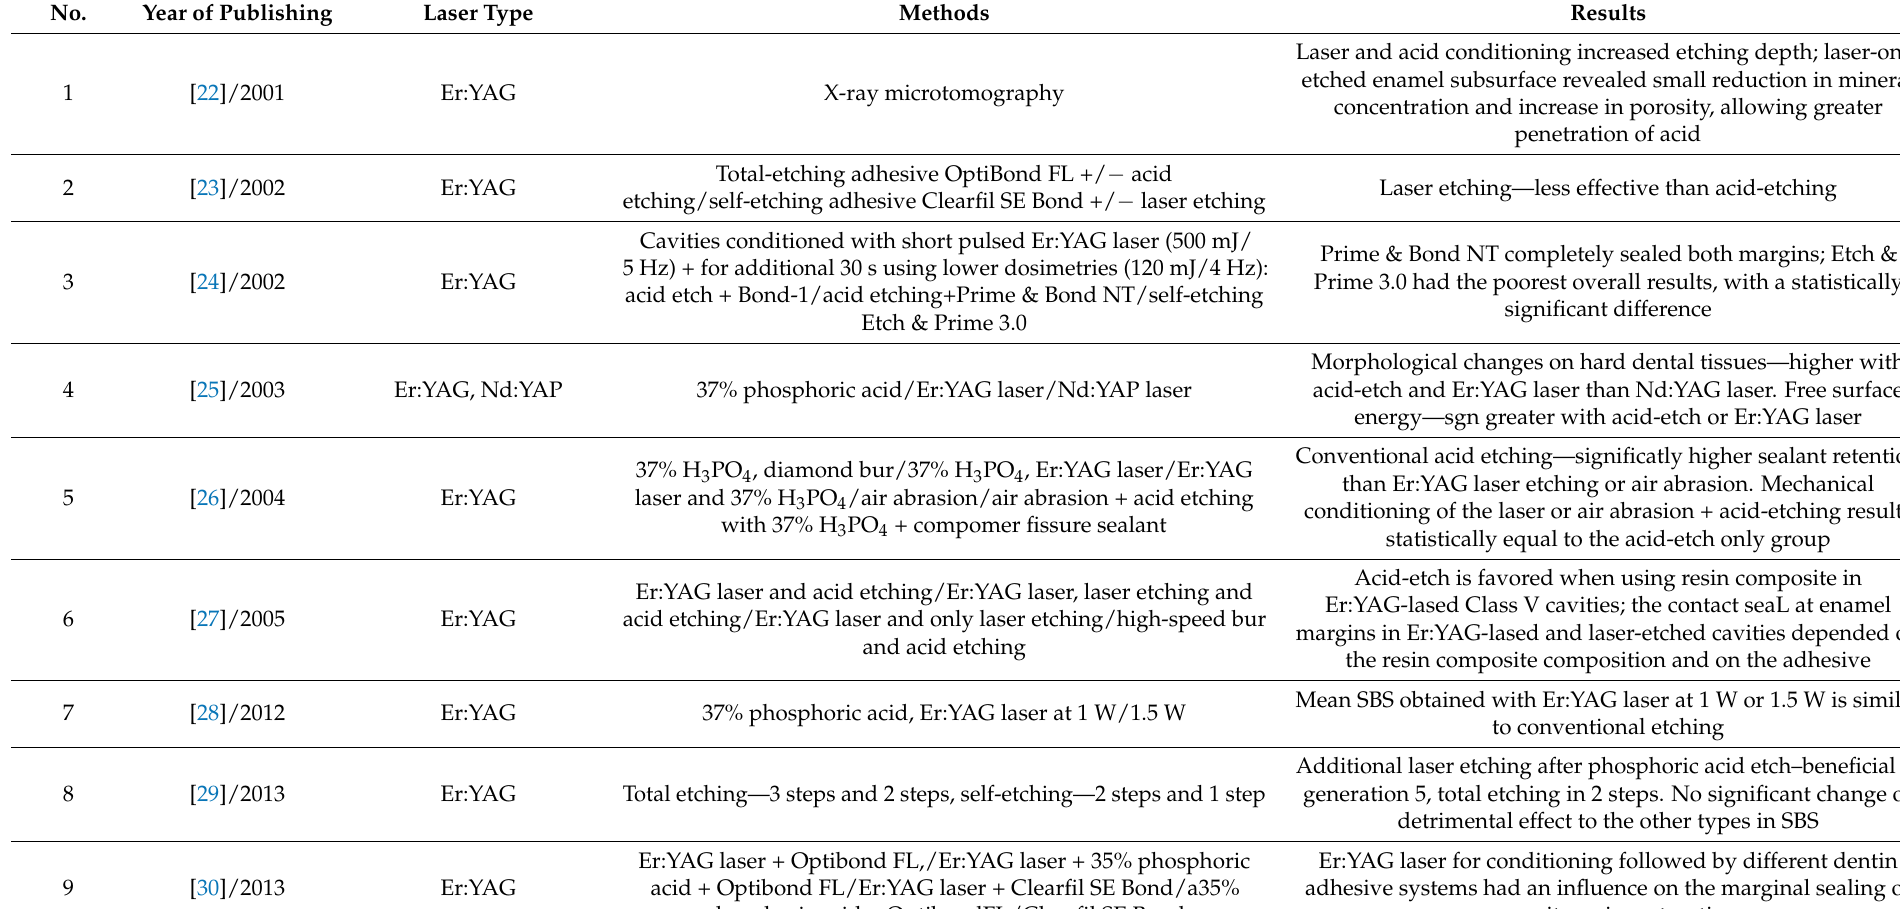
Table 2. Publications investigating Er:YAG laser for enamel